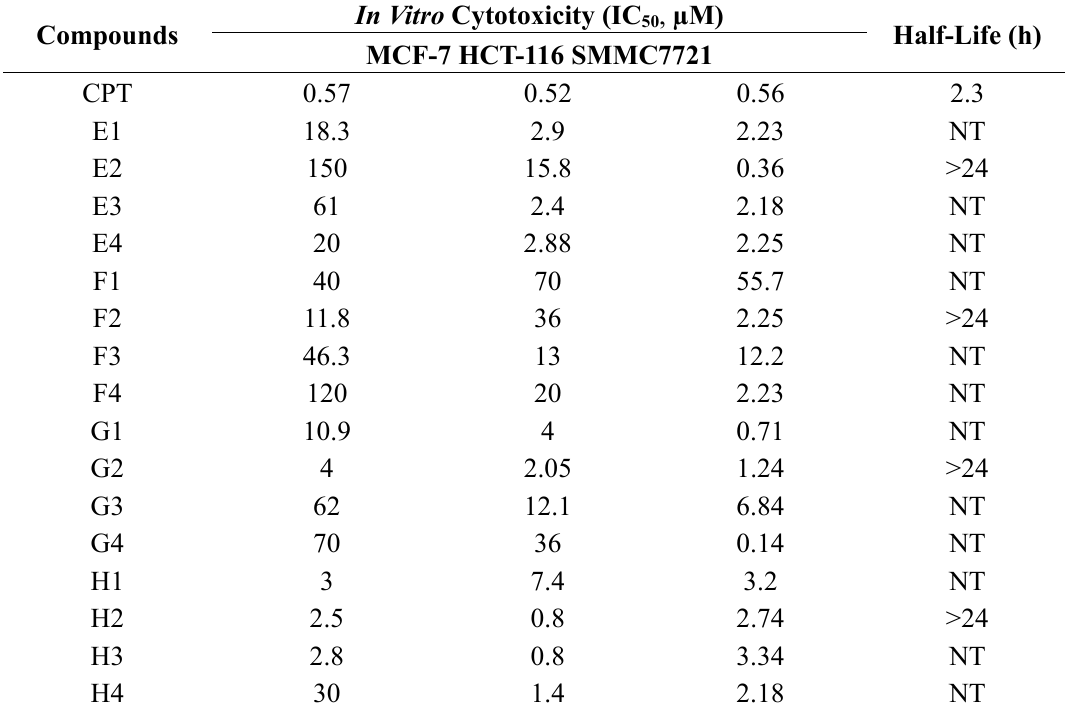
Table 1. Cytotoxicity of CPT-bile acid analogues.